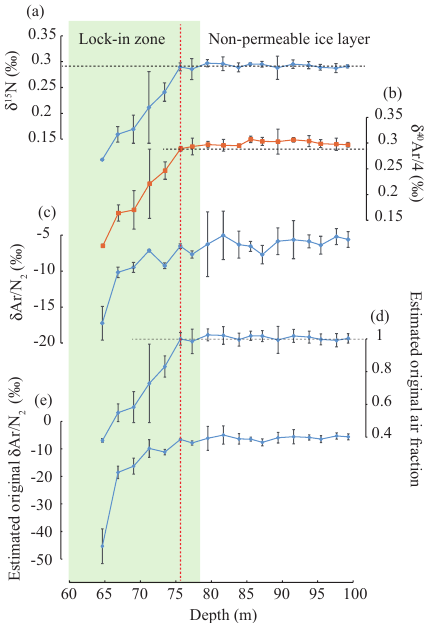
Figure 8. δ 15 N, δ 40 Ar/4, and δ Ar / N 2 in the NGRIP ice core from shallower depths (60–100m). (a) δ 15 N, (b) δ 40 Ar/4, (c) δ Ar / N 2 , (d) estimated original air fractions, and (e) estimated original δ Ar / N 2 . The estimated original air fractions relative to the value at 75.6m were calculated with a mass balance calculation, assuming that δ 15 N in the lock-in zone is constant with the value of 0.289‰ at 75.6m and δ 15 N of the ambient air is 0.0‰. From the calculated original air fraction, the original δ Ar / N 2 were estimated again by the mass balance calculation, assuming that the ambient δ Ar / N 2 is 0.0‰. The green shaded area indicates the lock-in zone. Black dot- ted lines in δ 15 N, δ 40 Ar, and the estimated original air fraction are the values at 75.6m (red dotted line).